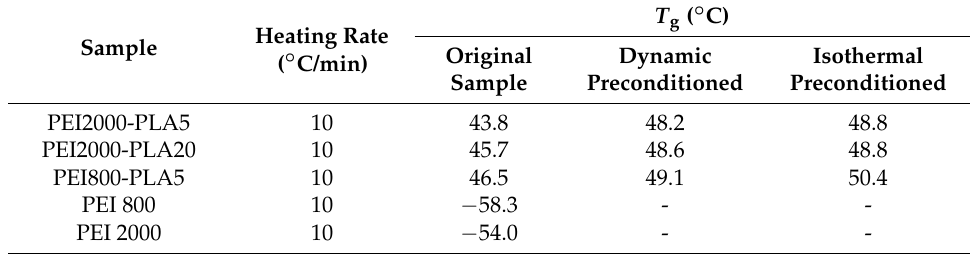
Table 2. Differential scanning calorimetry (DSC) results for the different samples investigated.